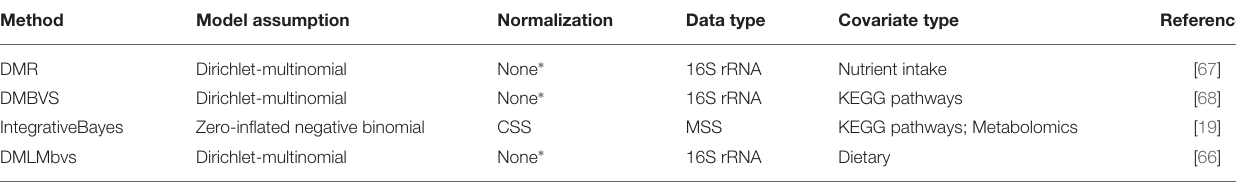
TABLE 6 | Summary of methods for integrative analysis in microbiome studies.